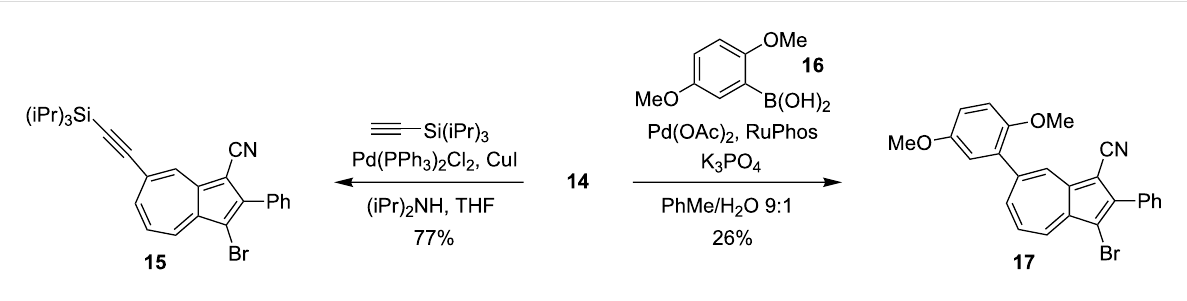
Scheme 7: Regioselective Sonogashira and Suzuki couplings. RuPhos = 2-dicyclohexylphosphino-2',6'-diisopropoxy-1,1'-biphenyl.